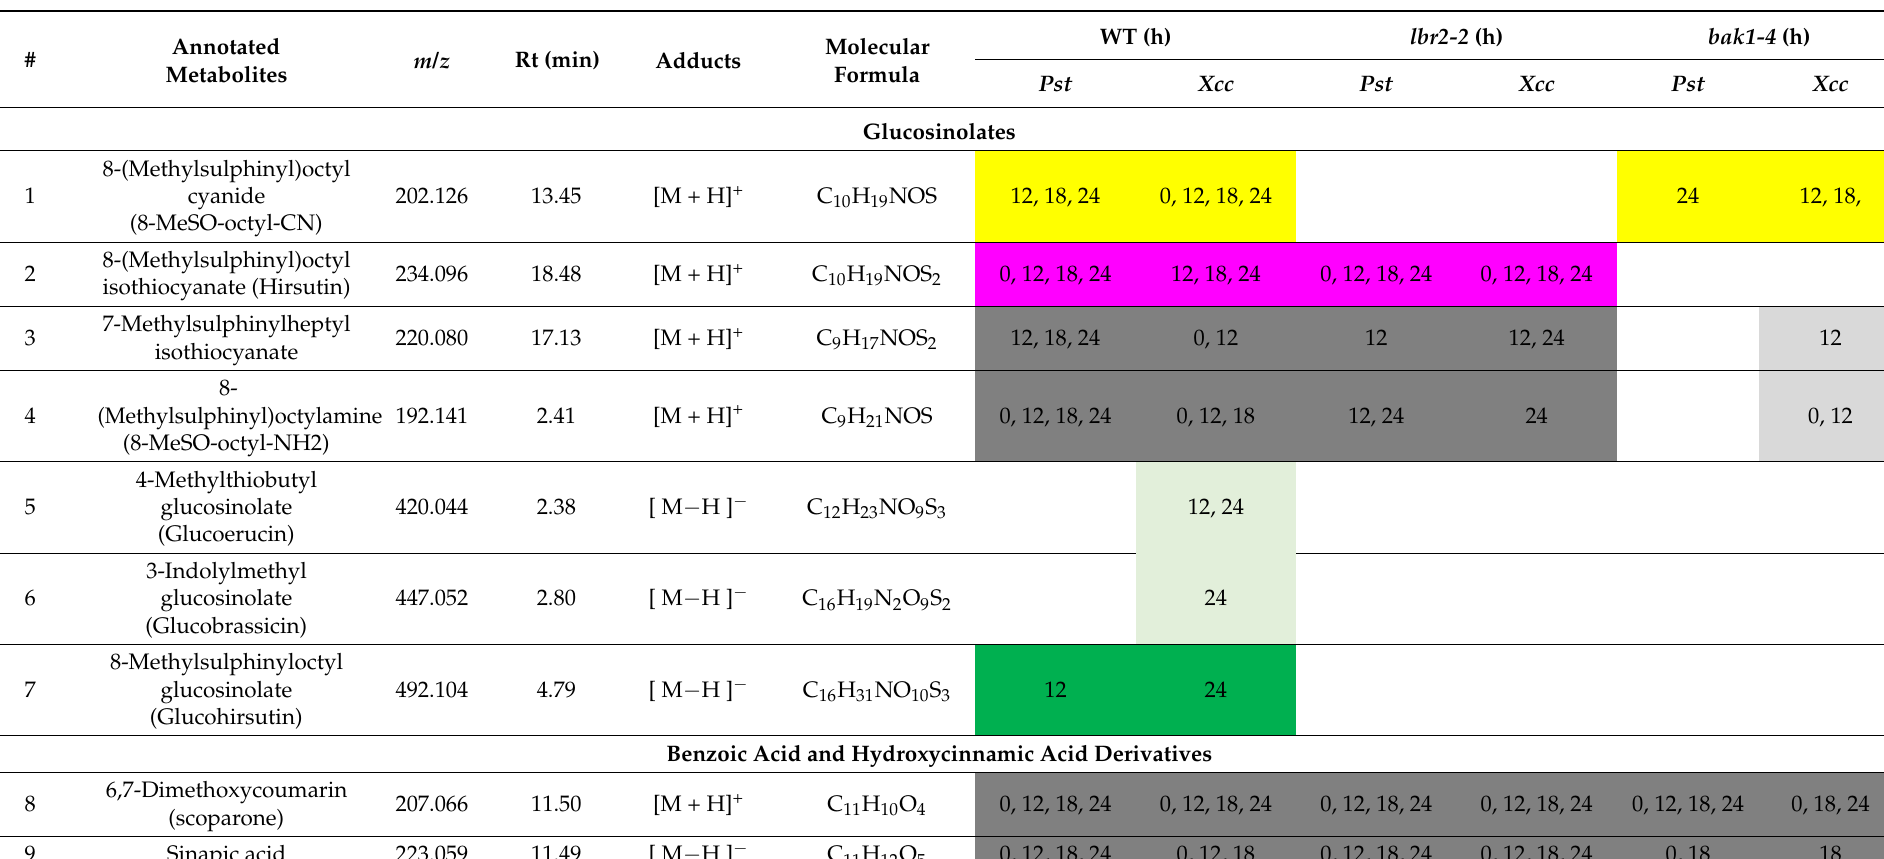
Table 1. Putatively annotated discriminatory metabolites, extracted from the OPLS-DA S-plots, for the Arabidopsis WT, lbr2-2 and bak1-4 leaves treated with LPS Pst and LPS Xcc chemotypes, and analysed in both ESI (+/ − ) MS modes. Metabolites that accumulated due to the specific LPS chemotype treatment after 0, 12, 18, and 24 h in WT, lbr2-2 and bak1-4 , respectively, are listed. Early and later time point LPS treatments are represented as 0–12 h and 18–24 h, respectively. Metabolites are coloured based for the plants they were identified in (only WT: green; WT and lbr2-2 : pink; WT and bak1-4 : yellow; only mutants: blue; all three lines: grey, and with a lighter shade for only one